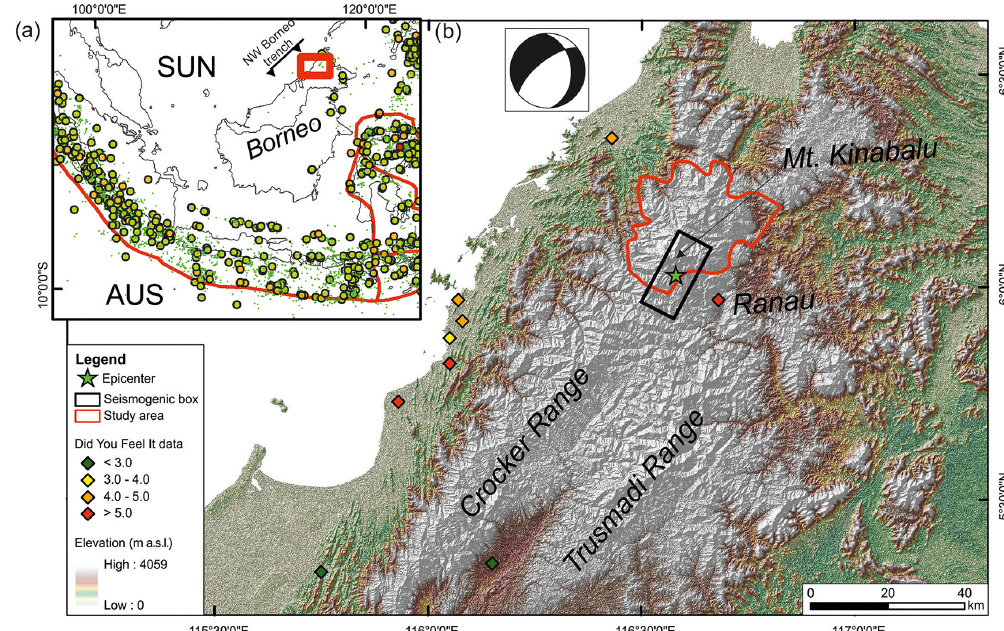
Figure 1. (a) Regional seismotectonic setting of SE Asia showing main plate boundaries and M > 5 earthquakes (USGS/NEIC catalog); AUS: Australian Plate, SUN: Sundaland block; the red rectangle marks the area enlarged in panel (b) . (b) Digital elevation model (DEM) derived from 30m resolution Advanced Land Observing Satellite (ALOS) DEM; the focal mechanism is from the USGS; epicenter and seismogenic box are after Wang et al. (2017); intensity data from the DYFI program are shown as